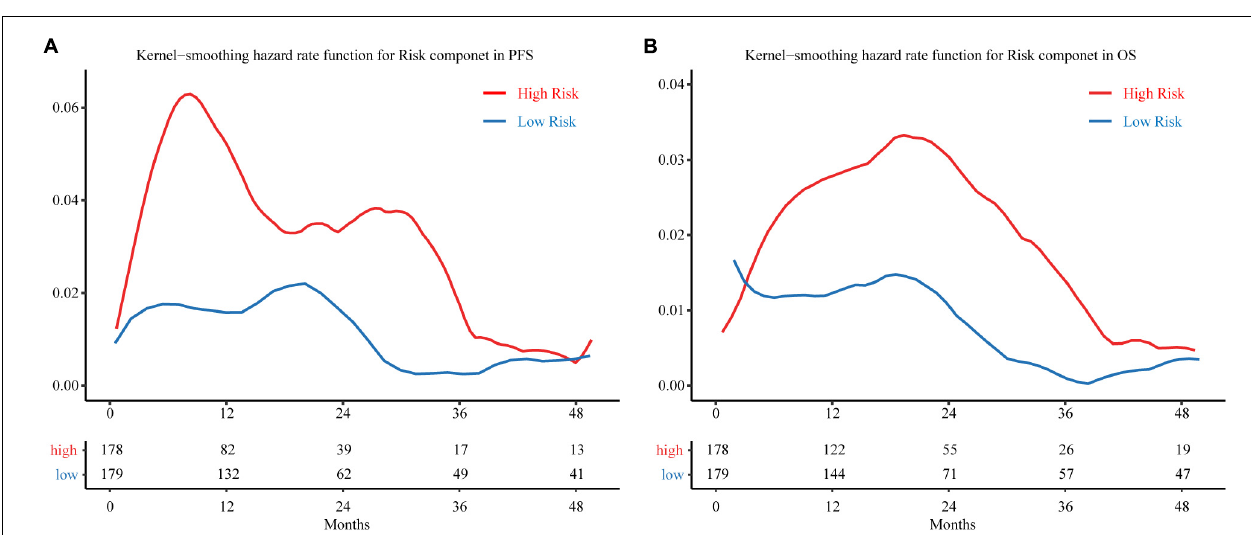
FIGURE 5 | Hazard curves revealing the time of cancer progression. Smoothed hazard estimates for the presence of a risk component in (A) PFS and (B) OS. The red line represents patients in the high-risk group, and the blue line represents patients in the low-risk group. The table below the curve gives the number of patients without observed endpoint event at different follow-up cut-of time. PFS, progression-free survival; OS, overall survival.